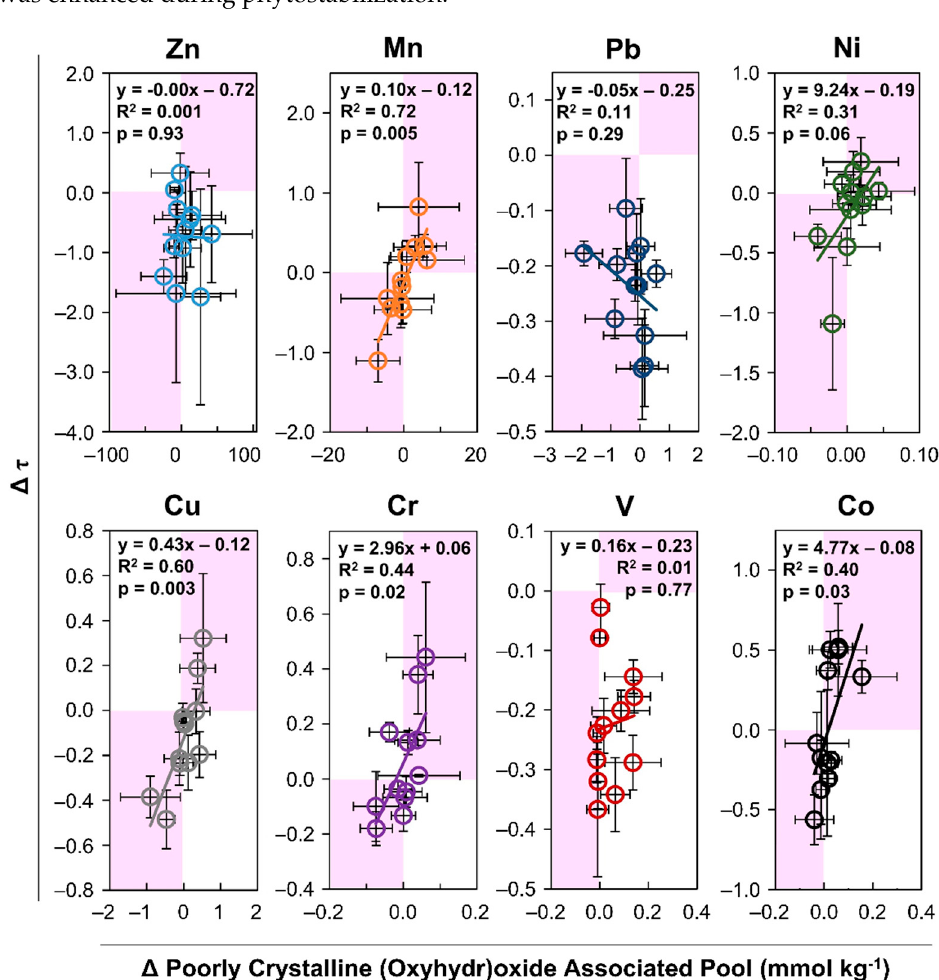
Figure 5. Temporal relationship between recalcitrant (oxyhydr)oxide-associated metals and enrich- ment/depletion. The relationship between the change in metal concentration over 3 years from poorly crystalline (oxyhydr)oxide-associated pools and change in enrichment/depletion ( ∆ τ ) for depth increments 0–20, 20–40, 40–60, and 60–90 cm for 0% compost control, 10% compost and seed, and 20% compost and seed treatments. Error bars show standard deviation from quadruplicate field plots, n = 4 for each depth and treatment. The statistical parameter R 2 indicates goodness of fit of a linear relationship according to the equation shown describing the best fit. A statistical parameter p -value < 0.05 describes a statistically significant linear slope reported for a 95% confidence interval ( α = 0.05, n = 12, for a two-tailed test).